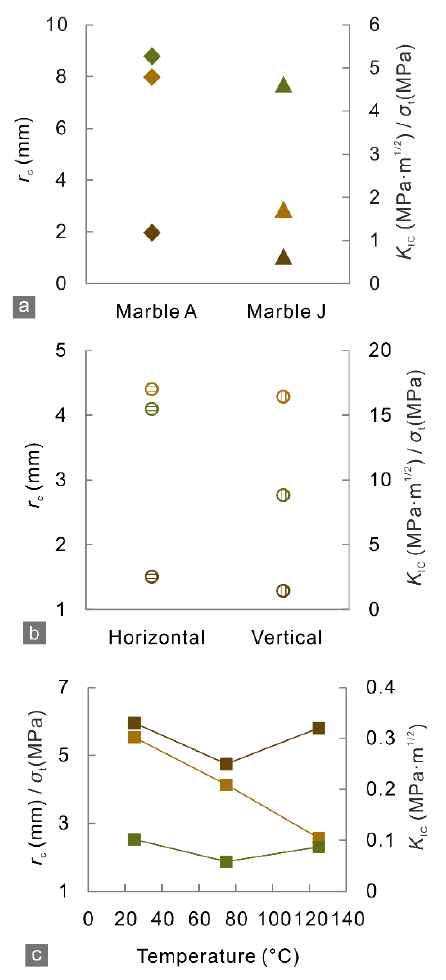
Figure 4. Mean tensile strength (brown), tensile fracture toughness (green), and crack tolerance (sienna) of the ( a ) marble A (diamond) and J (triangle), ( b ) shale (circle) with horizontal and vertical orientations and ( c ) sandstone (square).